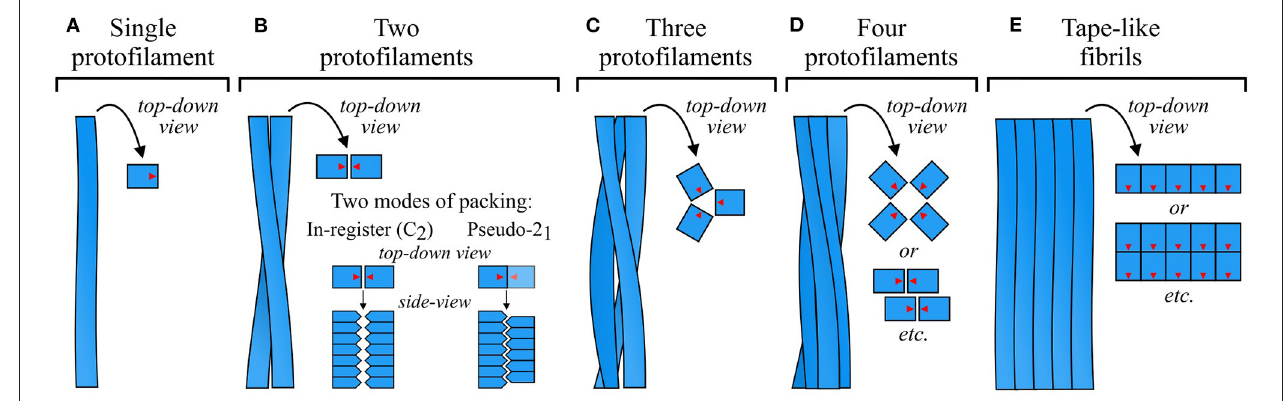
FIGURE 9 | Schematic of common modes of protofilament organization. Fibrils can be (A) a single protofilament, (B–D) a twisted ribbon or tubular structure formed by association of several protofilaments, often with rotational symmetry about the fibril axis, or (E) a tape-like side-by-side association of protofilaments. In the top-down schematics, blue squares with red arrows represent top-down views of subunits, with the red arrows showing their relative orientation in the subunit plane. In the side-on schematics for (B) , blue pentagons represent side views of protofilament subunits. As shown in this panel, twofold-symmetric fibrils or protofilament groups can have an in-register (C 2 ) association of laterally apposed subunit stacks, or a staggered (pseudo-2 1 ) organization in which the two stacks are half a β -sheet spacing out of register. While the former optimizes interactions that rely on alignment of the subunits in the same plane, the latter allows interdigitation of sidechains that protrude into the interface. The density map obtained by Mizuno et al. (2011) was used as a template for the schematic in (C) .